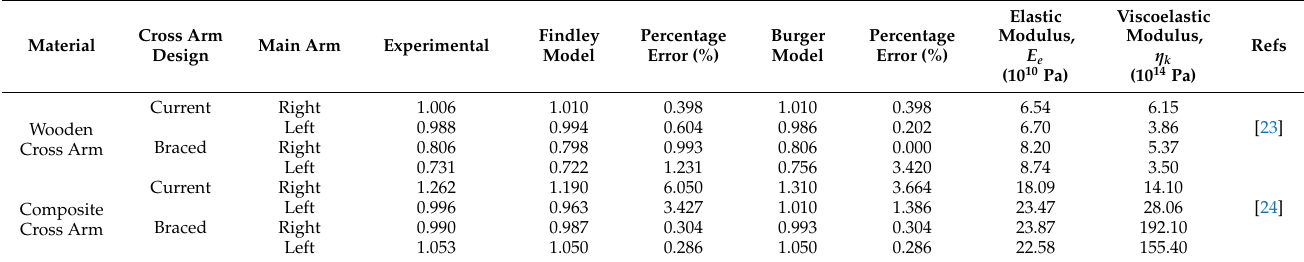
Table 7. Creep properties of wooden and pGFRP composite cross arms at the middle main member, y3.